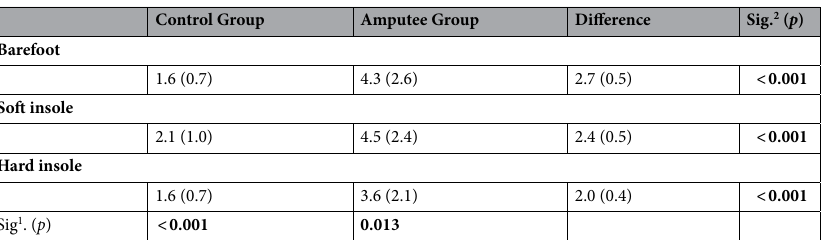
Table 8. Comparison of anterior velocity between the different insoles in each experimental group. Significant values are in [bold]. Mean (standard deviation) [IC. For the mean (at 95%)]. 1 Friedman Test. 2 Mann-Whitney Test. Anterior velocity